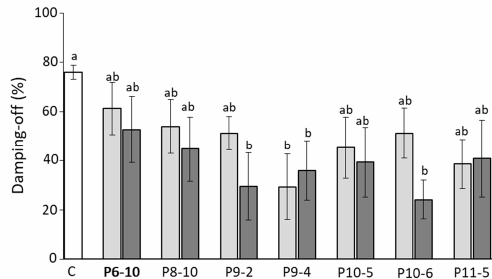
Figure 2. Control of Sclerotinia damping-off on rocket seedlings by the antagonistic spore-forming bacteria (x-axis) used in this study at two increasing concentrations, 10 7 (light grey bars) and 10 8 cfu mL − 1 (dark grey bars) compared to the untreated control (white bar). Bars are the mean values ± standard error; different lower-case letters indicate statistically significant differences between bars, according to Fisher’s LSD test ( p < 0.05).